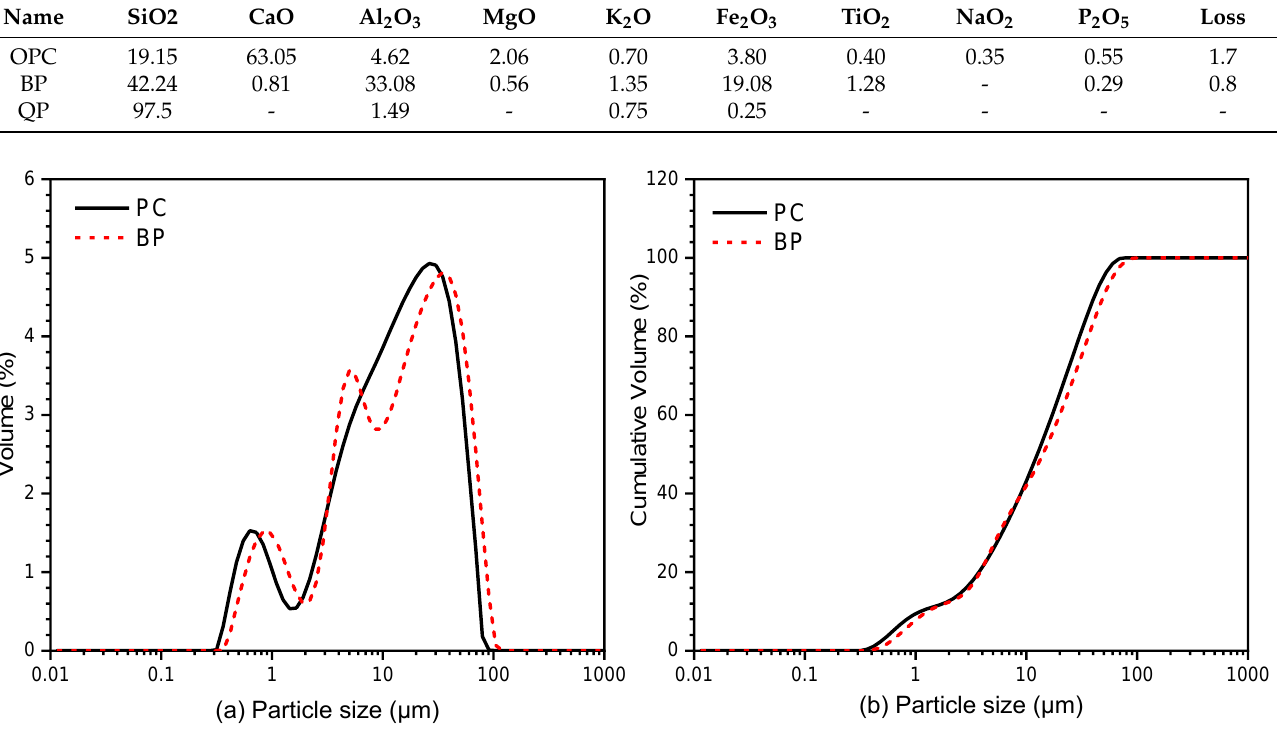
Figure 1. Particle size distribution ( a ) and cumulative particle size distribution ( b ) of OPC and BP.